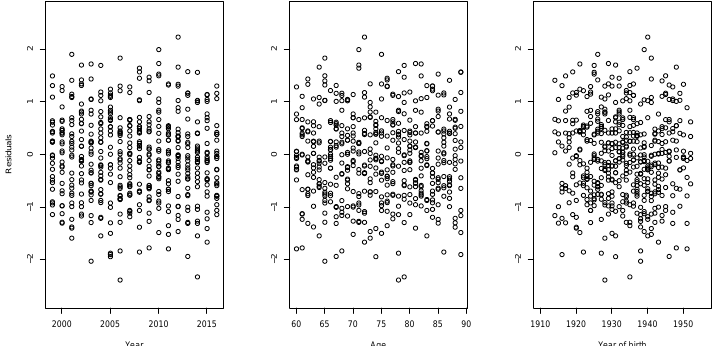
Figure 10. RH–LC deviance residuals for the male Maltese population.